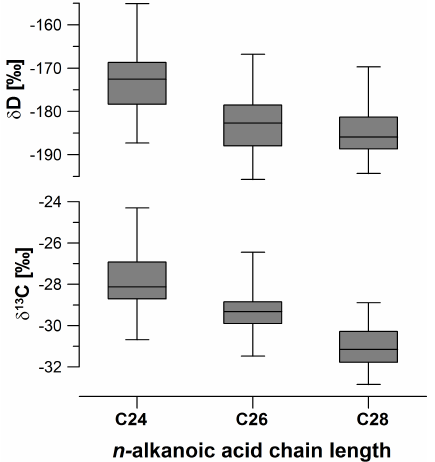
Figure 2. Box and whisker plots of δD and δ 13 C values in sediment samples by chain